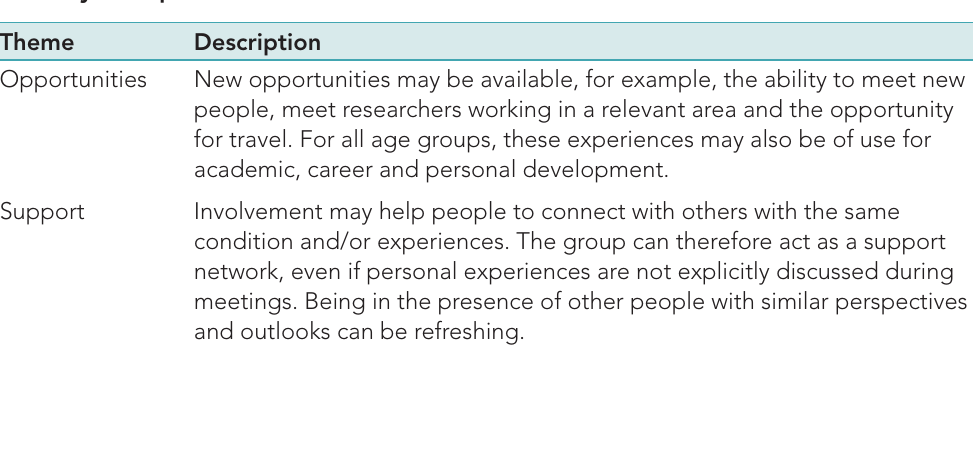
Table 3: Impact of involvement in research upon members of the Patient and Parent Advisory